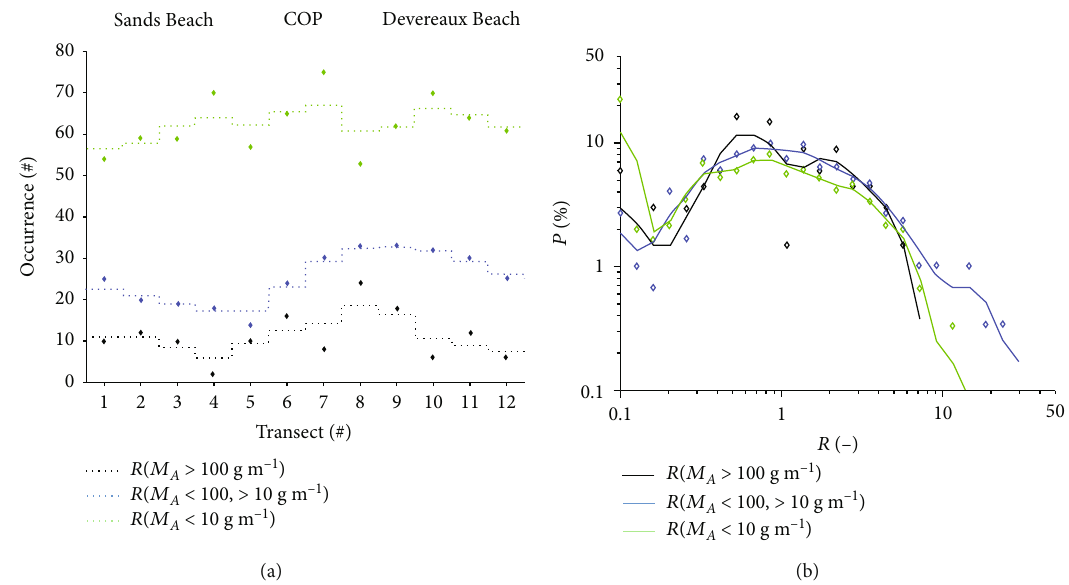
Figure 34: (a) Occurrence of tar aggregate in three aggregate mass ( M A ) regimes versus transect number, nearest neighbour smoothed (line) and unsmoothed (symbol). (b) Probability ( P ) of tar mass accumulation ratio ( R ) de fi ned as (tar ball sizes 1 & 2)/(tar ball sizes 3 & 4) for three aggregate mass regimes nearest neighbour smoothed (line) and unsmoothed (symbol). Data key on fi